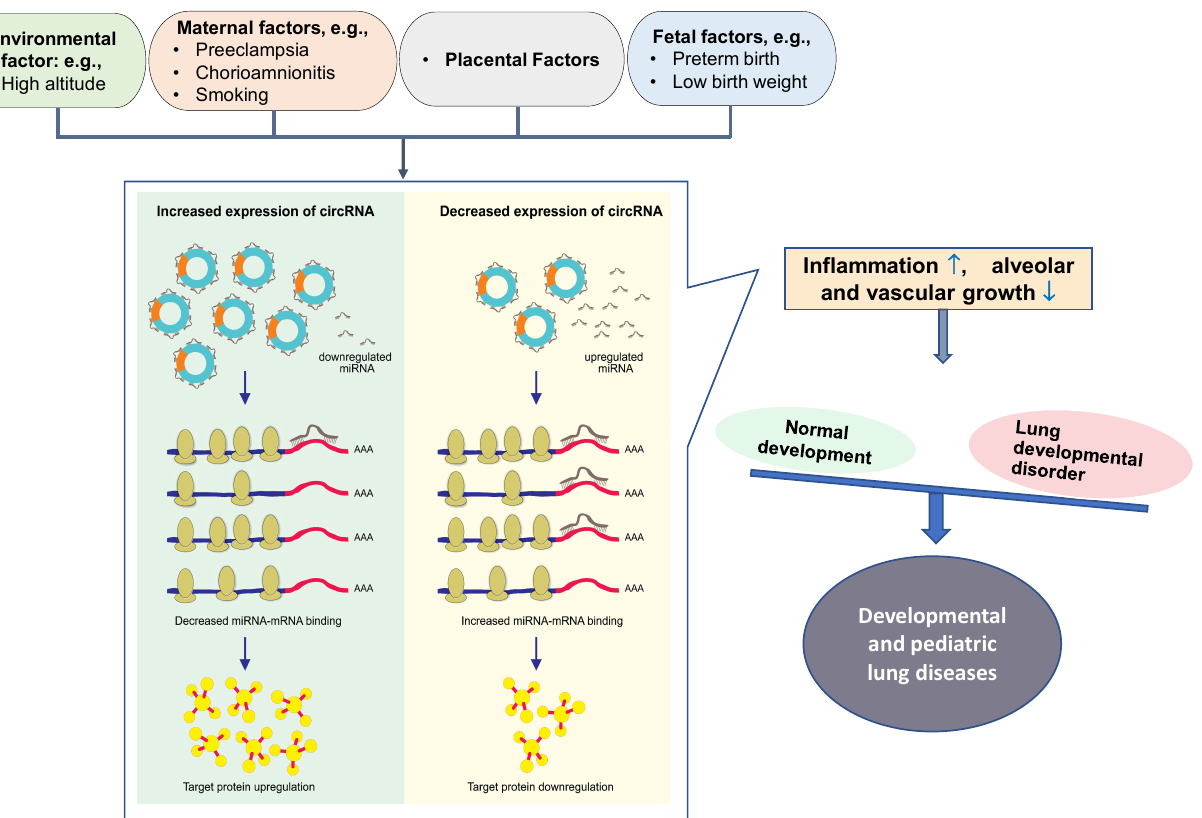
Figure 3. Schematic diagram of circRNA-miRNA interaction on controlling developmental and pediatric lung diseases. CircRNAs contain miRNA-binding sites. Maternal-fetus risk factors cause the alteration of circRNAs in placenta or/and circulation. Increased circRNAs can absorb more miRNAs, leading to miRNA downregulation; this reduces miRNA-mRNA binding, thereby upregulating miRNA target gene expression and protein translation. Conversely, decreased circRNAs and circRNA-miRNA interaction will downregulate miRNA target gene expression and protein translation. Eventually, the dysregulated proteins involved in the abnormal lung development can in-